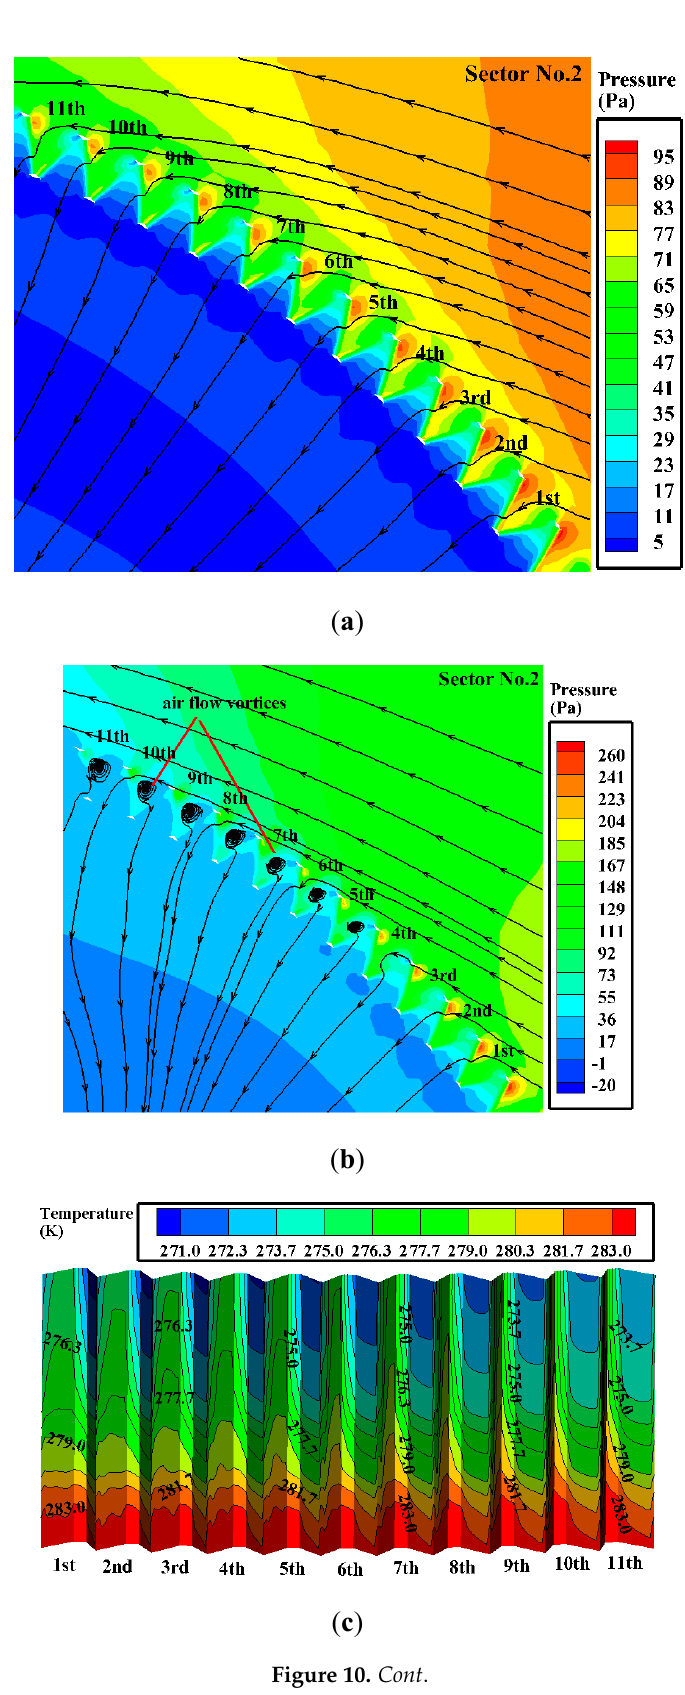
Figure 9. Thermo-flow performances of the frontal deltas. ( a ) Air mass flow rate, ( b ) heat rejection.